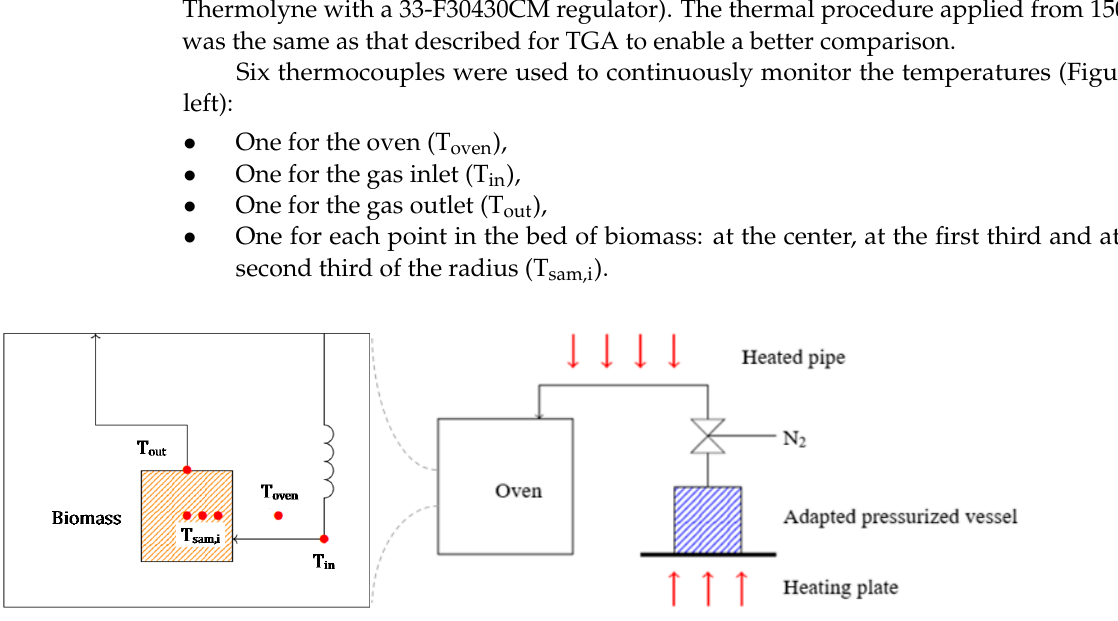
Figure 1. Scheme of the lab-scale facility for torrefaction under moist atmosphere (H 2 O, 100% v/v ) with the detail of the interior of the oven ( left ).